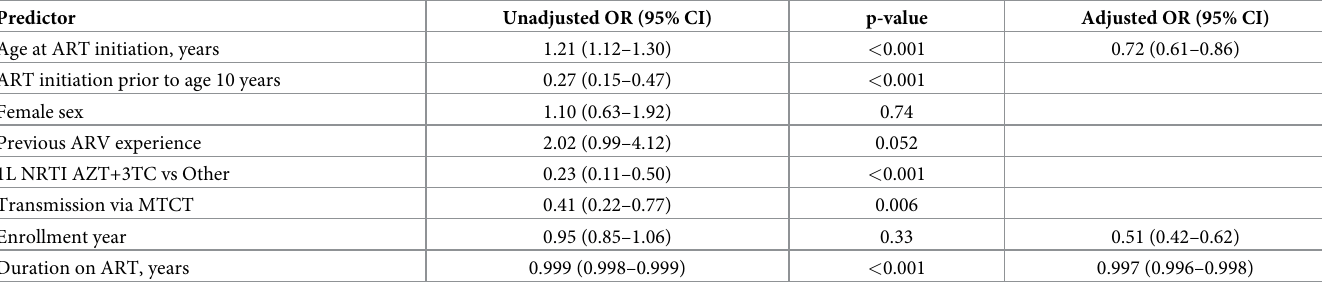
Table 2. Predictors of loss to follow-up from child-centered care among adolescent patients on antiretroviral therapy. Predictor